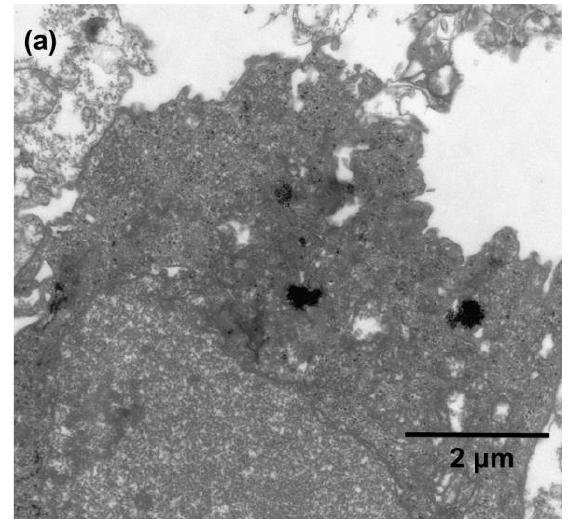
Figure 7. TEM image of an MCF-7 cell loaded with Fe 3 O 4 @Au pNPs.